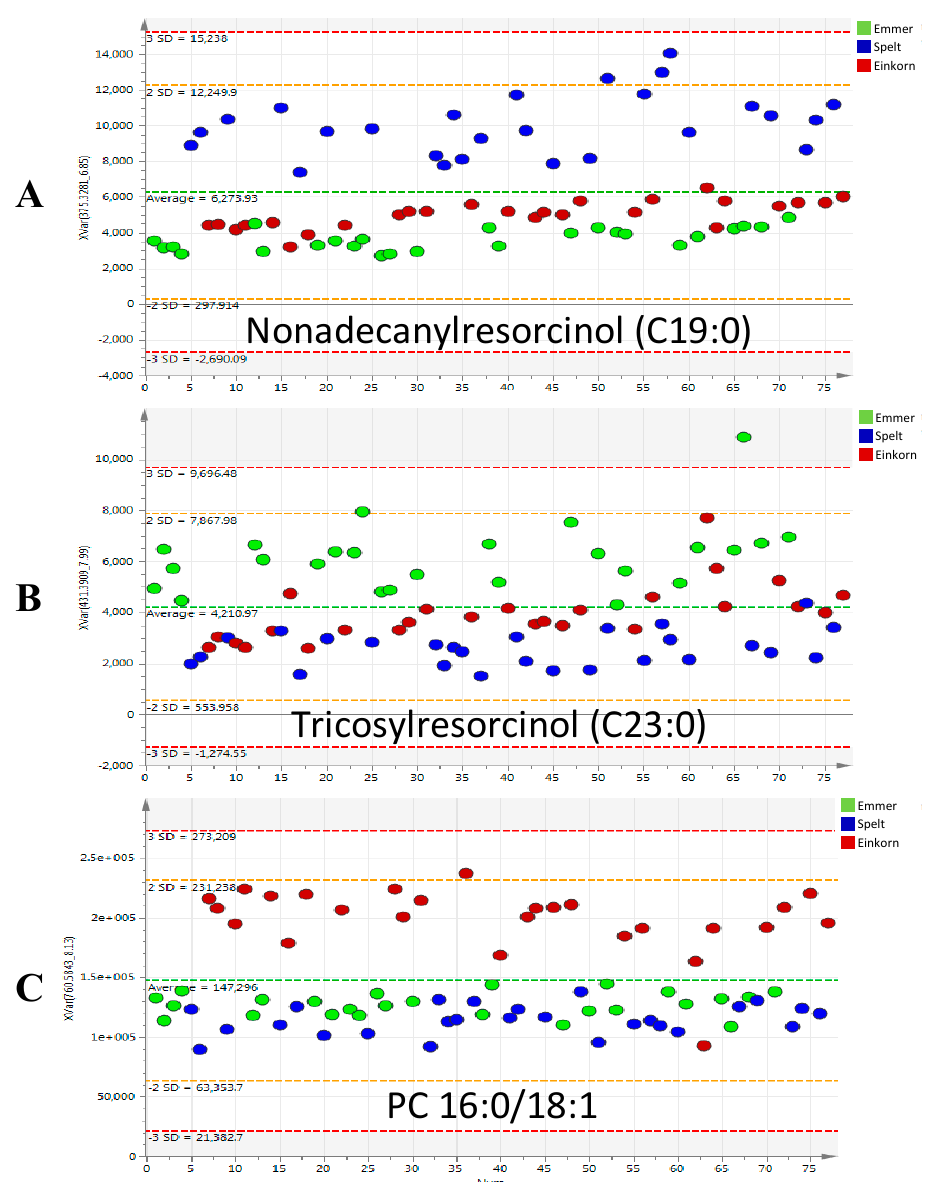
Figure 4. Variable trend plots of the most discriminant markers: nonadecanylresorcinol (C19:0), overexpressed in the spelt variety Spelt (Rouquin) ( A ), tricosylresorcinol (C23:0) marker having the highest influence to discriminate emmer variety (Garfagnana) ( B ) and PC (16:0/18:1), significantly higher in the einkorn variety (ID331) ( C